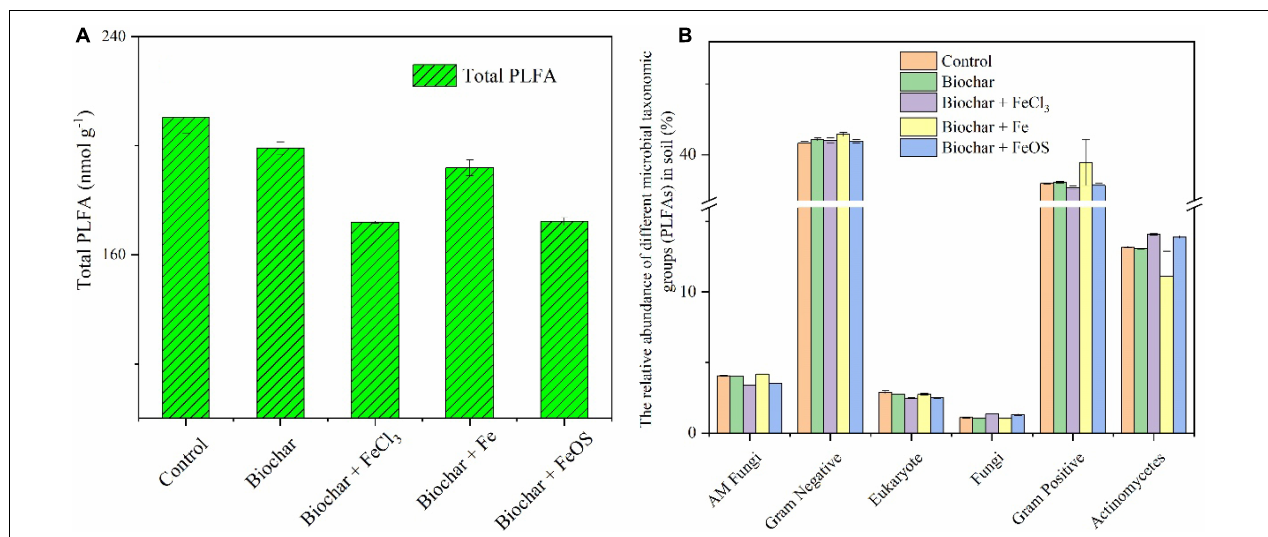
FIGURE 5 | The influence of iron modified biochar on the total biomass (A) and the relative abundance of different microbial taxonomic groups (B) (PLFAs) in soil.